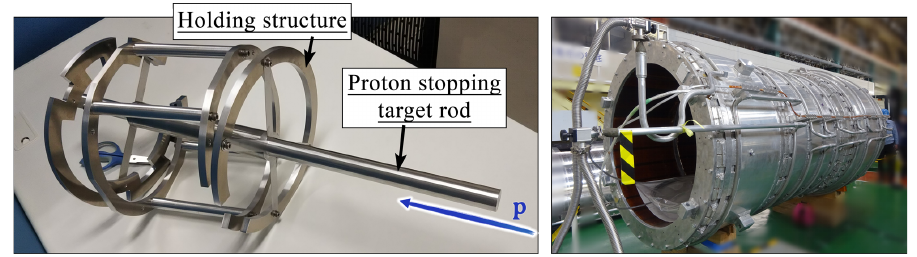
Figure 2. Status of parts in the pion production region. Left: Mock-up of the Phase-I proton target. Right: Outer hull of the pion capture solenoid.